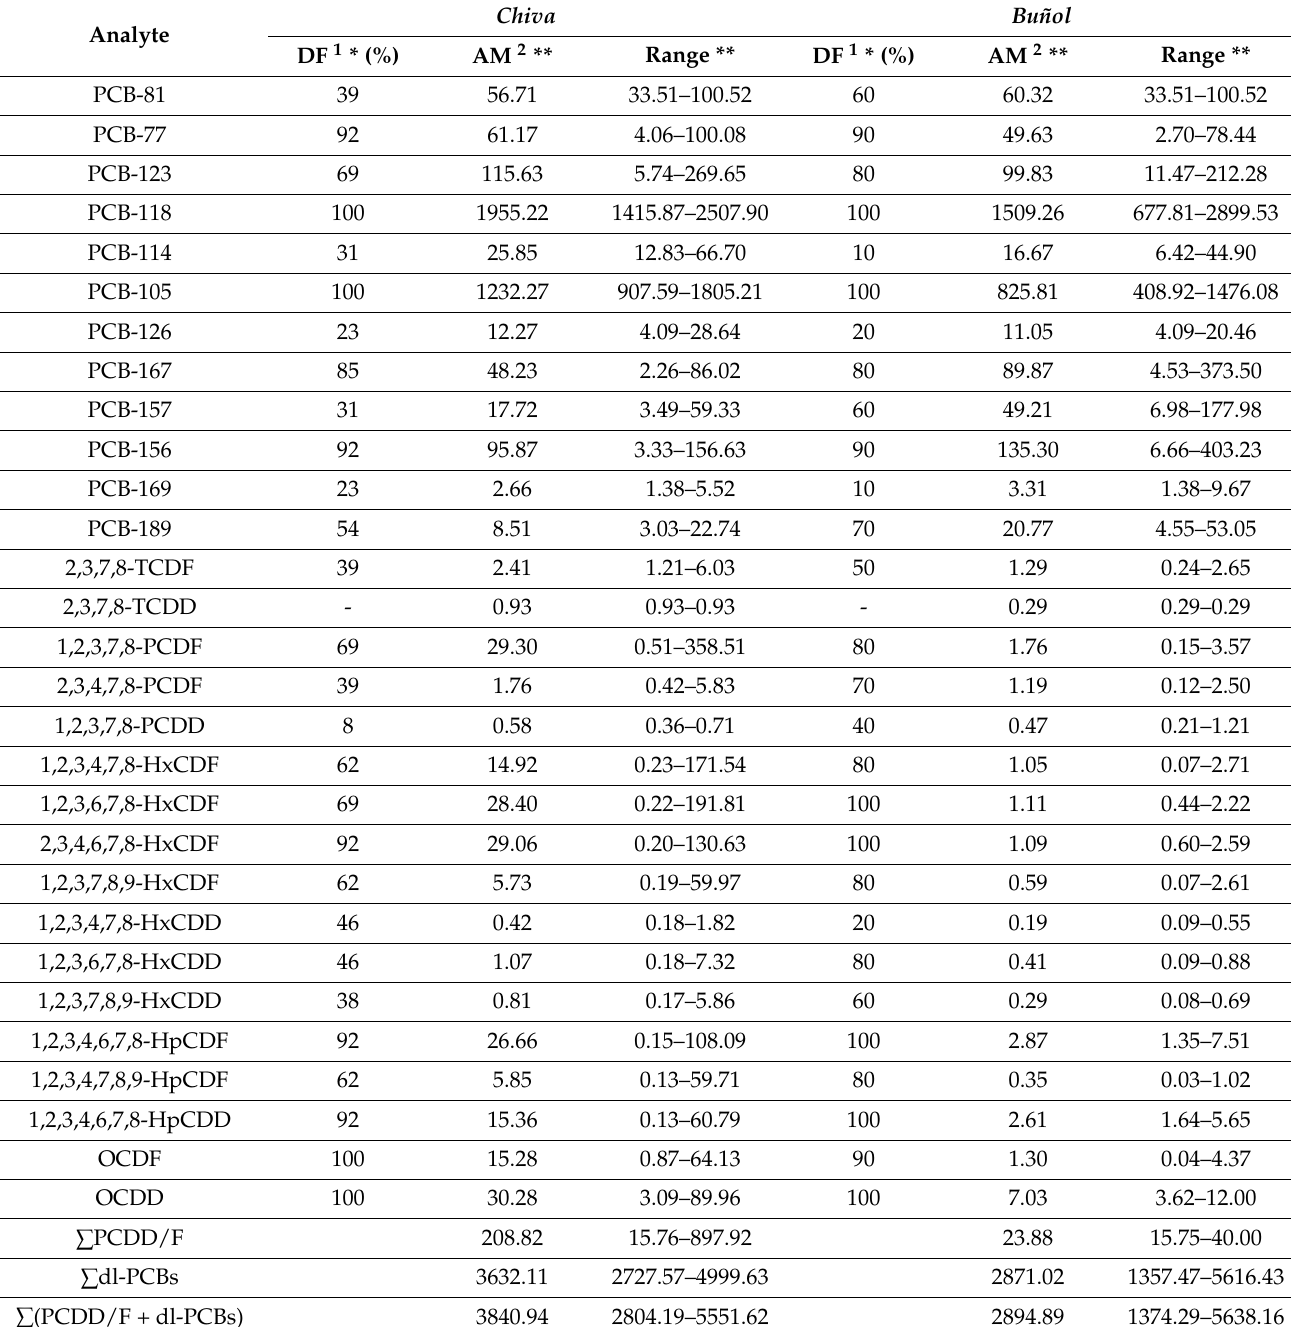
Table 3. Obtained results per congeners (fg/m 3